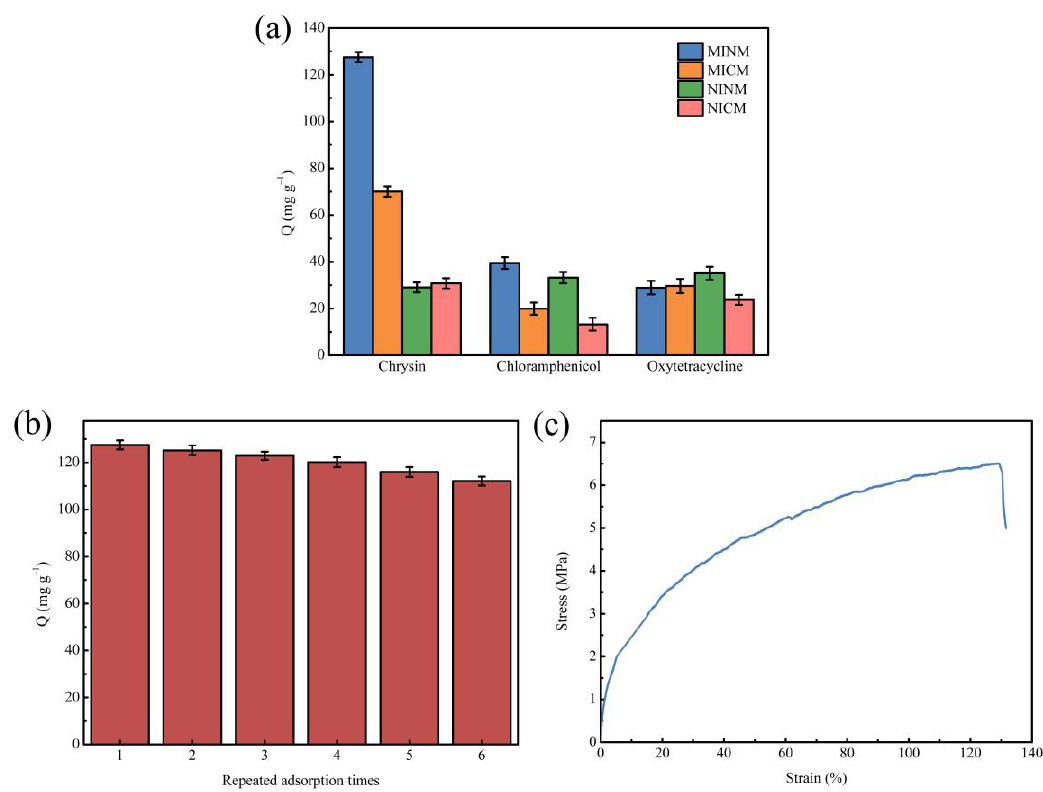
Figure 5. ( a )The selective adsorption capacity of MINM, MICM, NINM, and NICM; ( b ) regeneration rebinding performance of MINM; ( c ) stress – strain curve of MINM.